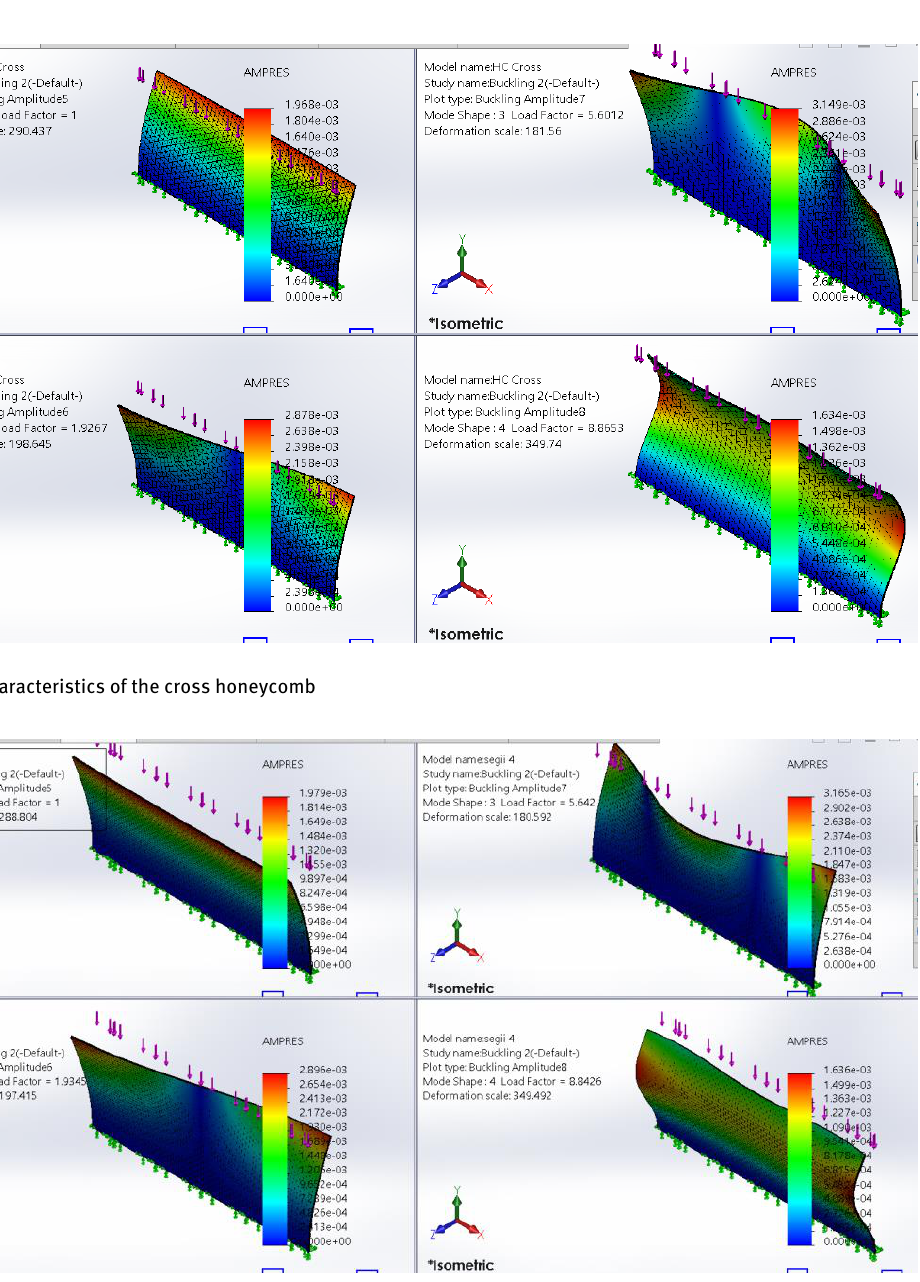
Figure 35: Buckling characteristics of the square